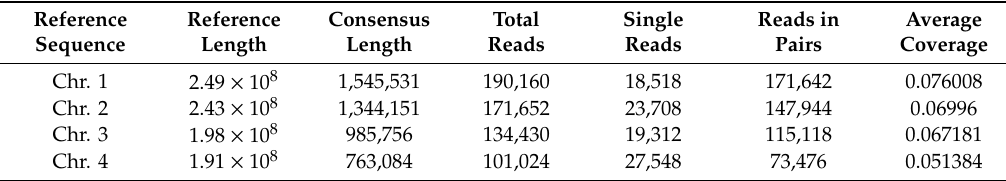
Table 1. The mapped reads and average coverage of hepatitis B virus (HBV) sequence capture-based next-generation sequencing in the present